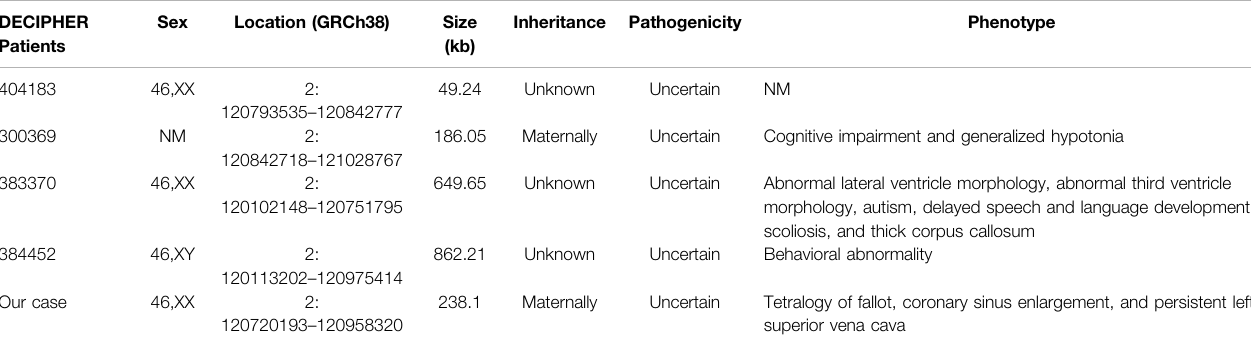
TABLE 1 | Cases with less than 1.0-Mb duplications in the 2q14.2 region are presented in the DECIPHER